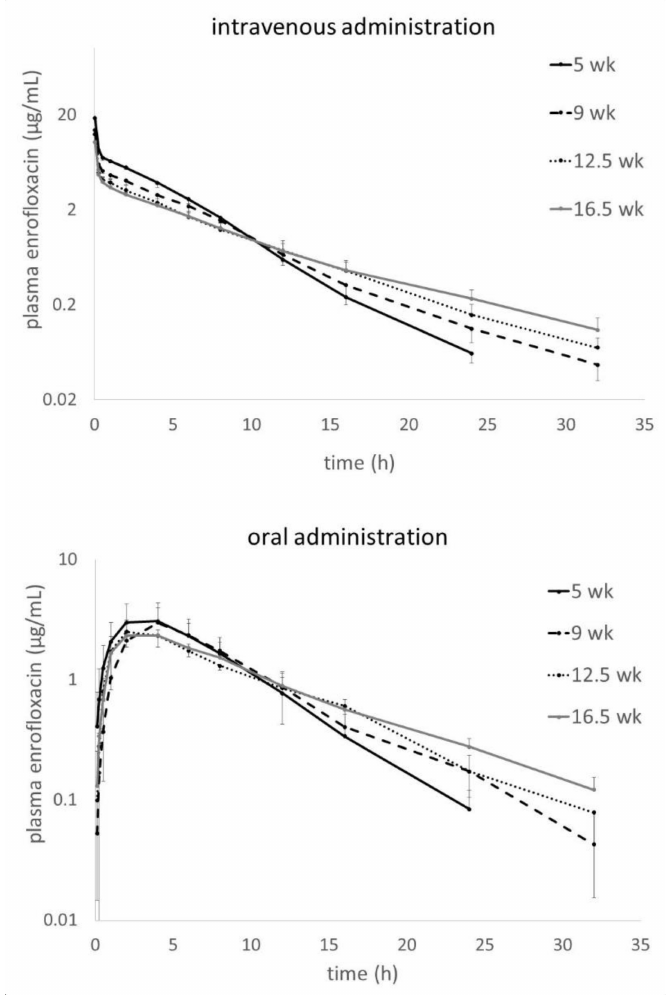
Figure 1. Plasma enrofloxacin concentrations after single intravenous (upper panel) and oral dose (lower panel) calculated according to the protocol: Dose = 30 × BW 0.59